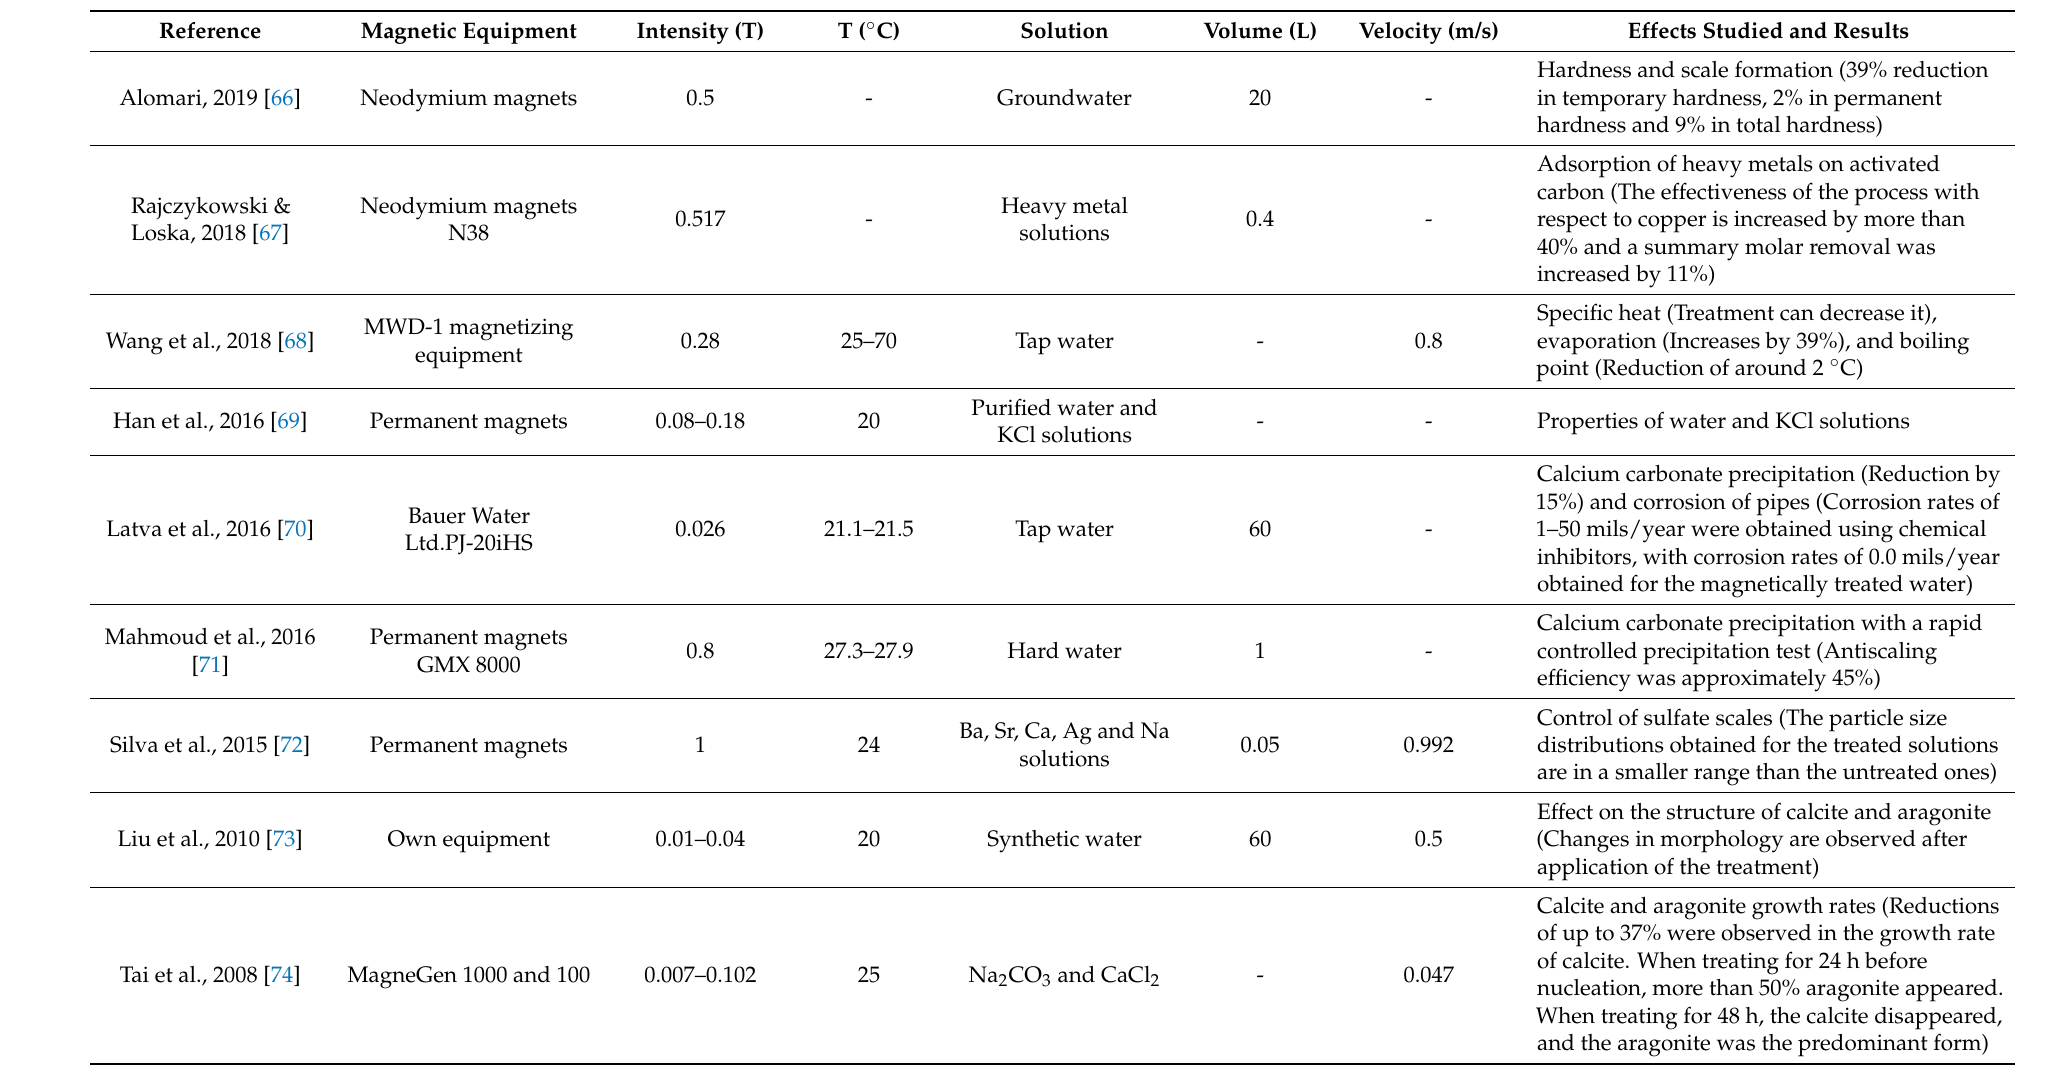
Table 3. Magnetic equipment used in the literature (own